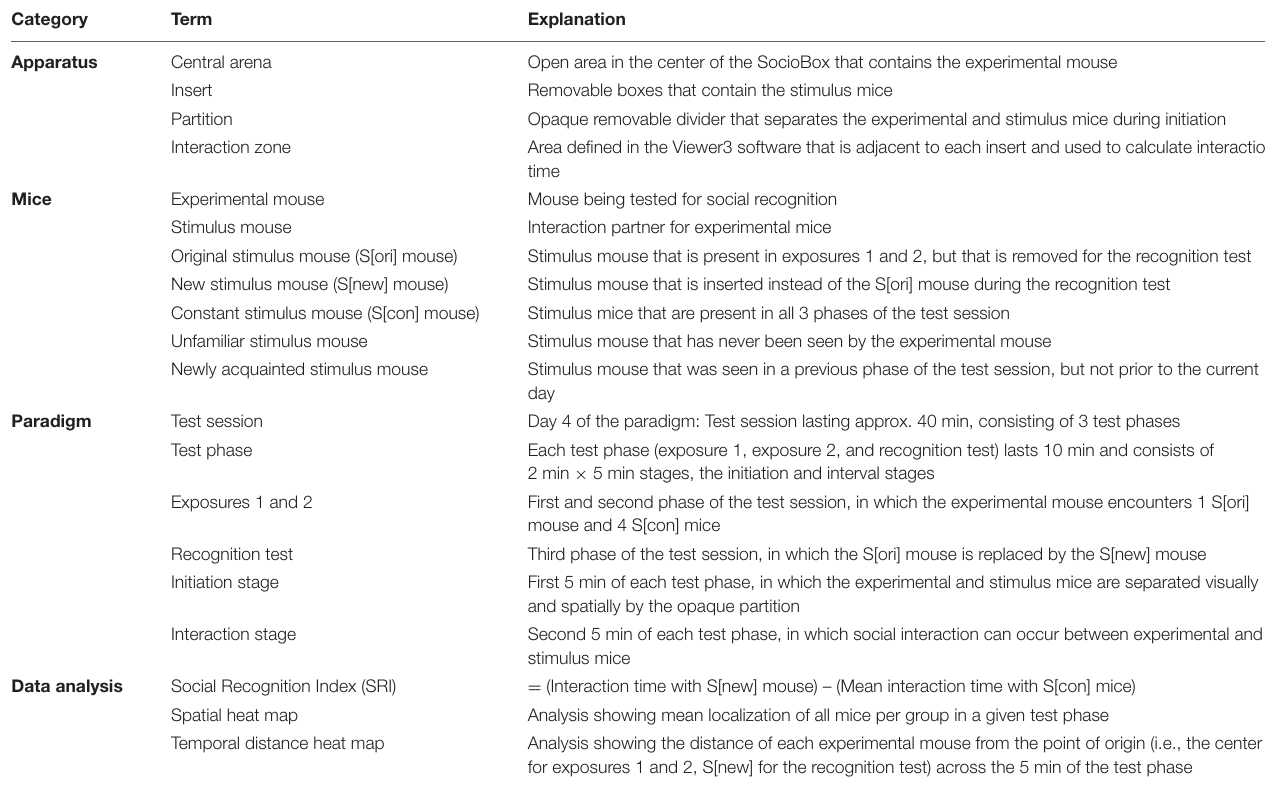
TABLE 1 | Glossary of the SocioBox